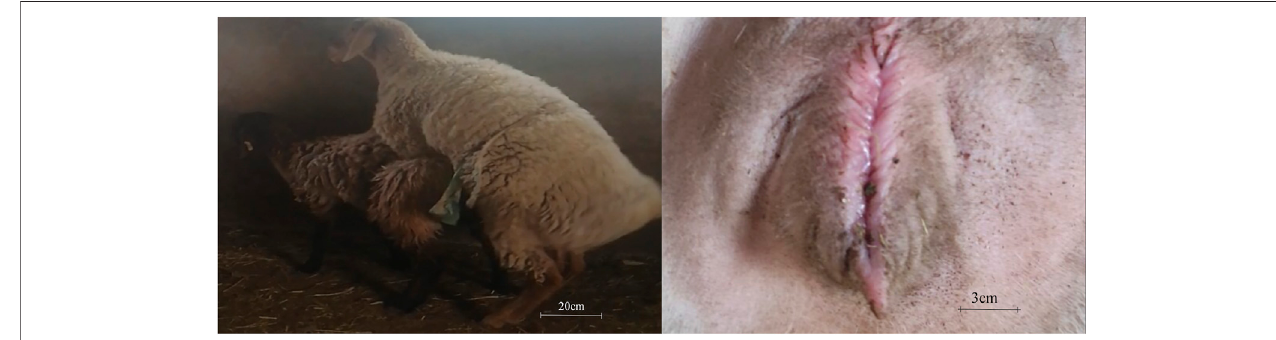
FIGURE 1 | Ewes undergoing puberty were de fi ned as those receptive to climbing by rams and mucus-laden